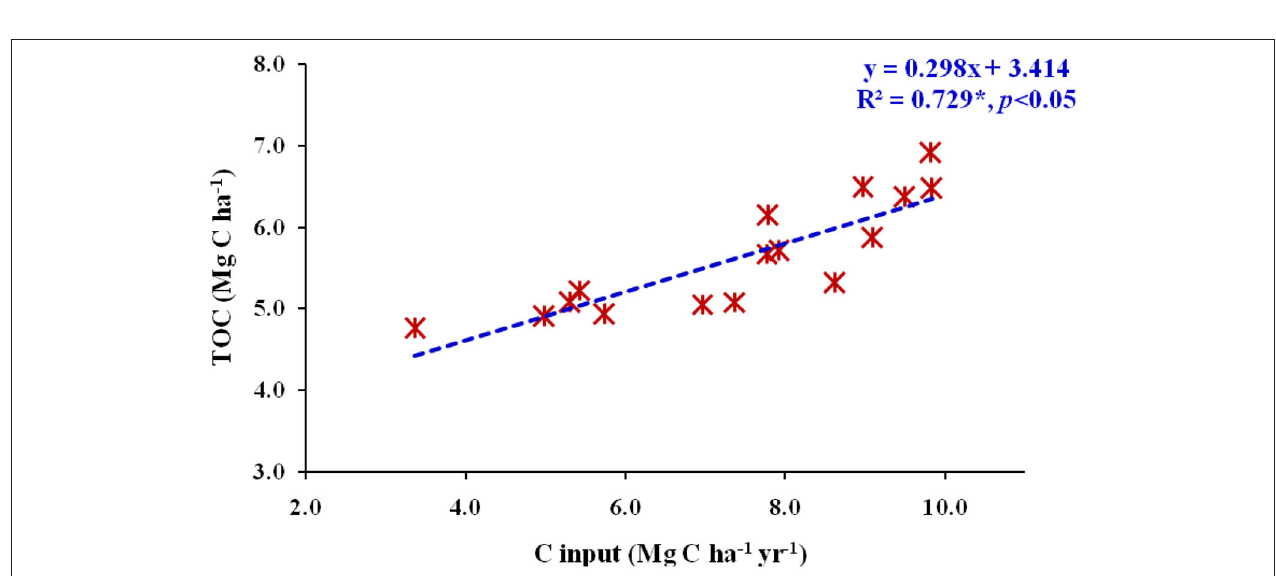
between total annual C input (through above-and below-ground biomass) into the soil plow layer (0–15 cm) and TOC after 6 cycles of RWCS. The relationship could best be